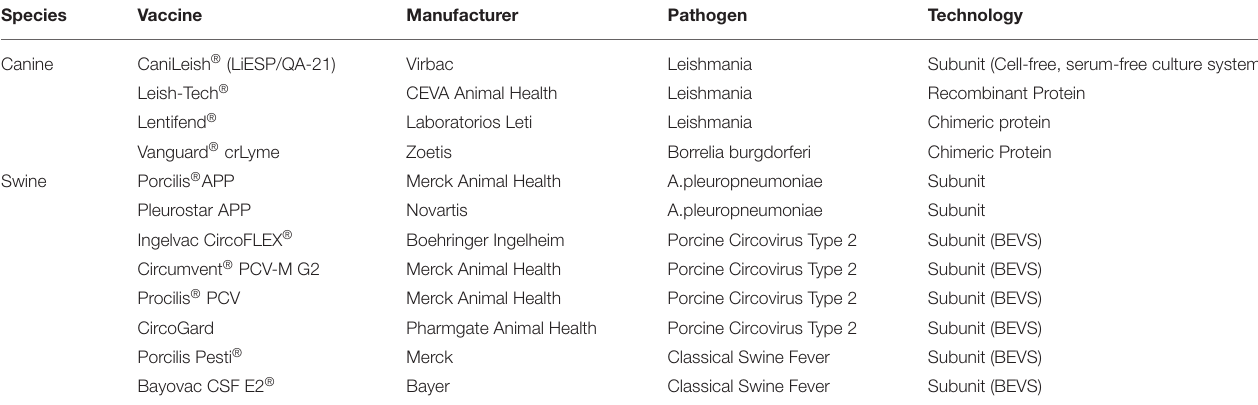
TABLE 1 | Subunit and recombinant protein vaccines.